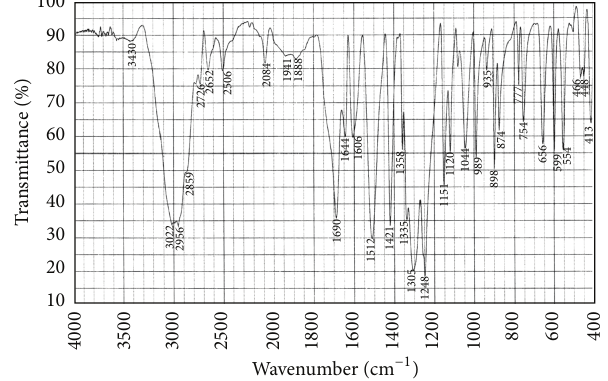
peaks in the pattern is more. As Table 1 shows, all the relative deviations between the calculated and experimental 𝑑 ℎ𝑘𝑙 are less than 0.5%. This indicates that the resultant is a single-phase compound with monoclinic symmetry. The crystal structure of arsenic triiodide belongs to hexagonal system (JCPDS card 7-272). Although the crystal structure of L -aspartic acid also belongs to monoclinic system (JCPDS card 23-1519), the lattice parameters ( 𝑎 = 0.7608 nm, 𝑏 = 0.6966 nm, 𝑐 = 0.5122 nm, and 𝛽 = 99.44 ∘ ) of L -aspartic acid Figure 2: Infrared spectra of title complex. are very different from the lattice parameters ( 𝑎 = 1.0019 nm, 𝑏 = 1.5118 nm, 𝑐 = 2.1971 nm, and 𝛽 = 100.28 ∘ ) of